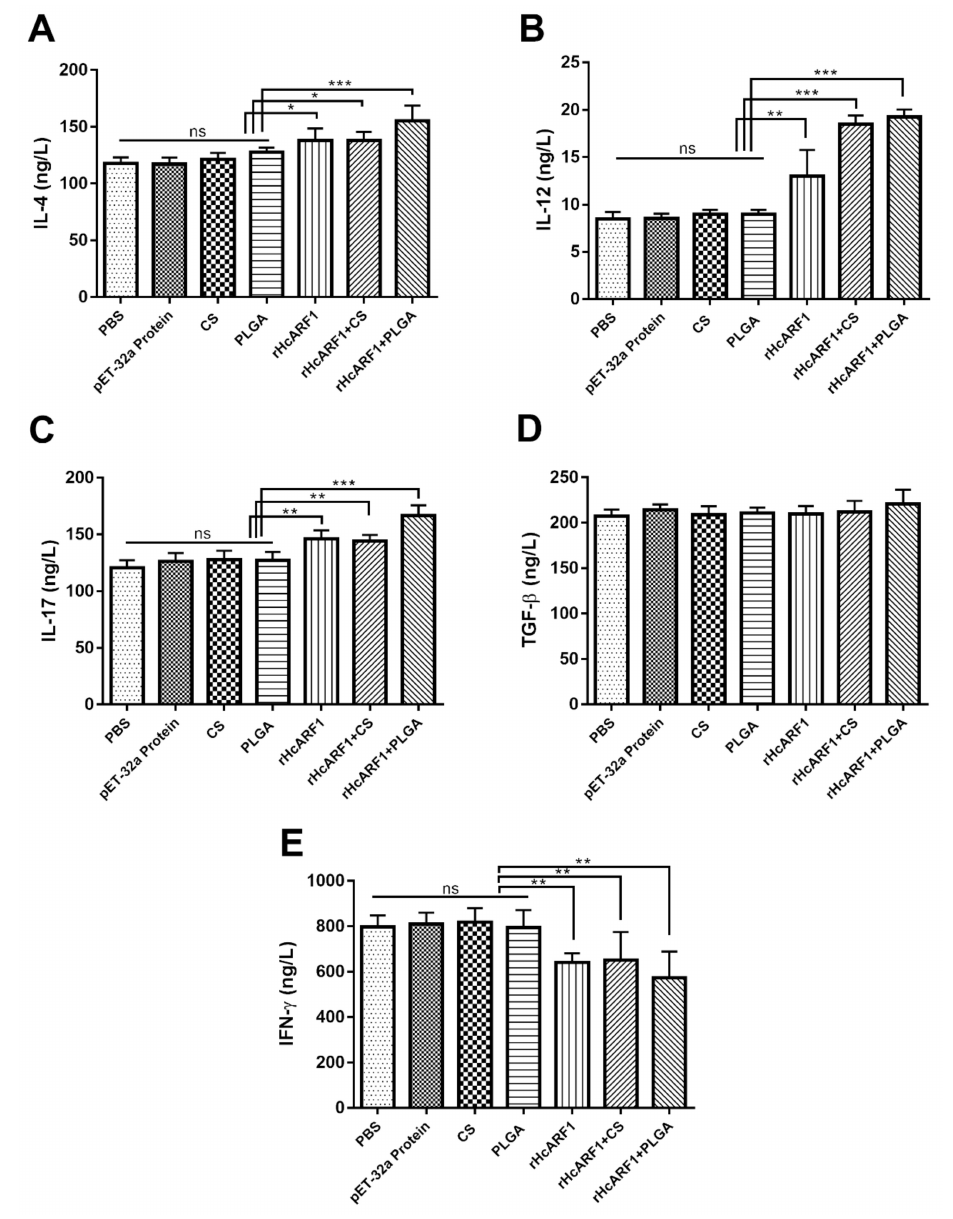
Figure 4. E ff ects of di ff erent antigen delivery systems on multiple cytokines expression. The sera were collected from mice before sacrificed and detected the cytokine released on the 14th day of experiment. Cytokine secretions for IL-4 ( A ), IL-12 ( B ), IL-17 ( C ), TGF- β 1 ( D ) and IFN- γ ( E ) in the serum samples of mice quantified by ELISA. Data are representative of independent experiments triplicate in each (* p < 0.05, ** p < 0.01, *** p <